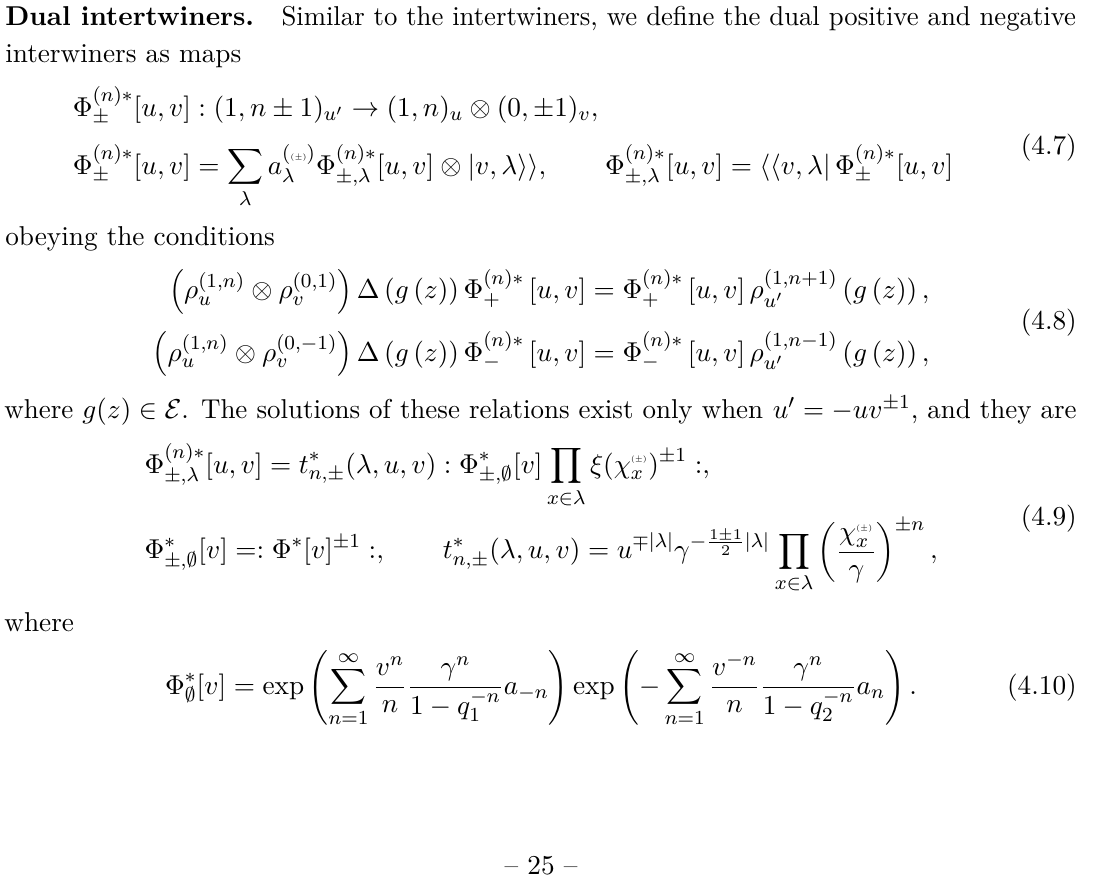
Figure 3 . Simplified picture of intertwiners. We draw the vertical lines representing NS5-branes as straight lines. The bending of the NS5-branes are represented by the levels written beside them. Note that we have two types of intertwiners and dual intertwiners: the positive one ( σ = 1 ) and the negative one ( σ = − 1